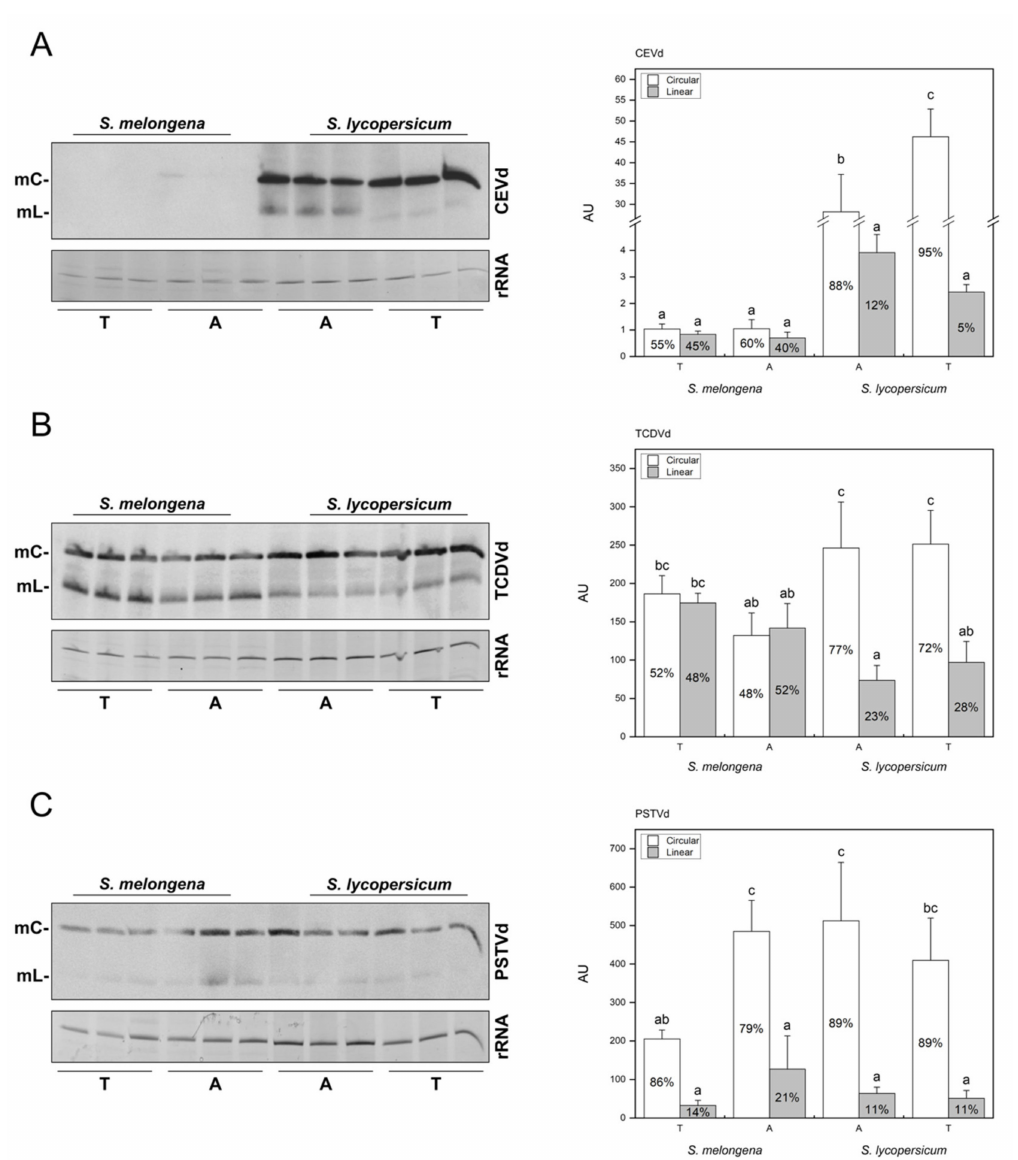
Figure 3. Viroid accumulation in S. lycopersicum and S. melongena . Northern blot assay and quantification for detecting plus polarity circular (mC) and linear (mL) viroid molecules in systemic tissue of transcript-inoculated plants (T) or by agro-inoculation and quantification of viroid accumulation in infected plants for CEVd ( A ), TCDVd ( B ), and PSTVd ( C ). Bars correspond to absolute AU values, and percentage of each form over total viroid values are printed inside the bars. Data correspond to the mean ± SD of 3 biological replicates. Results were analyzed using an ANOVA test with a Tukey post-hoc, and different letters indicate significant differences ( p ≤